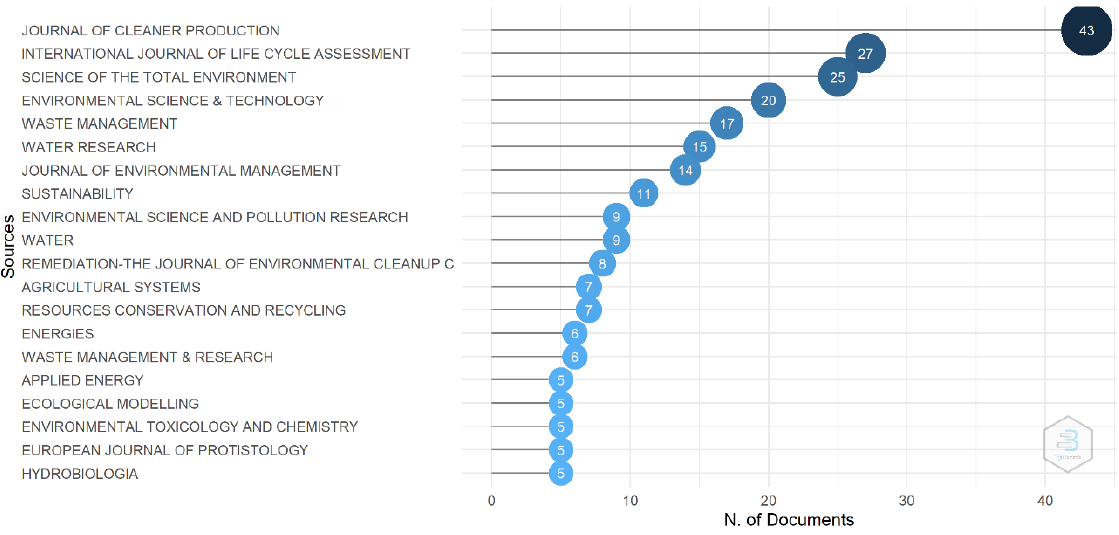
Figure 5. Journals with the highest number (N.) of documents in the field of study. Documents: 306 documents only from Scopus and 158 from WoS and 316 from both databases.